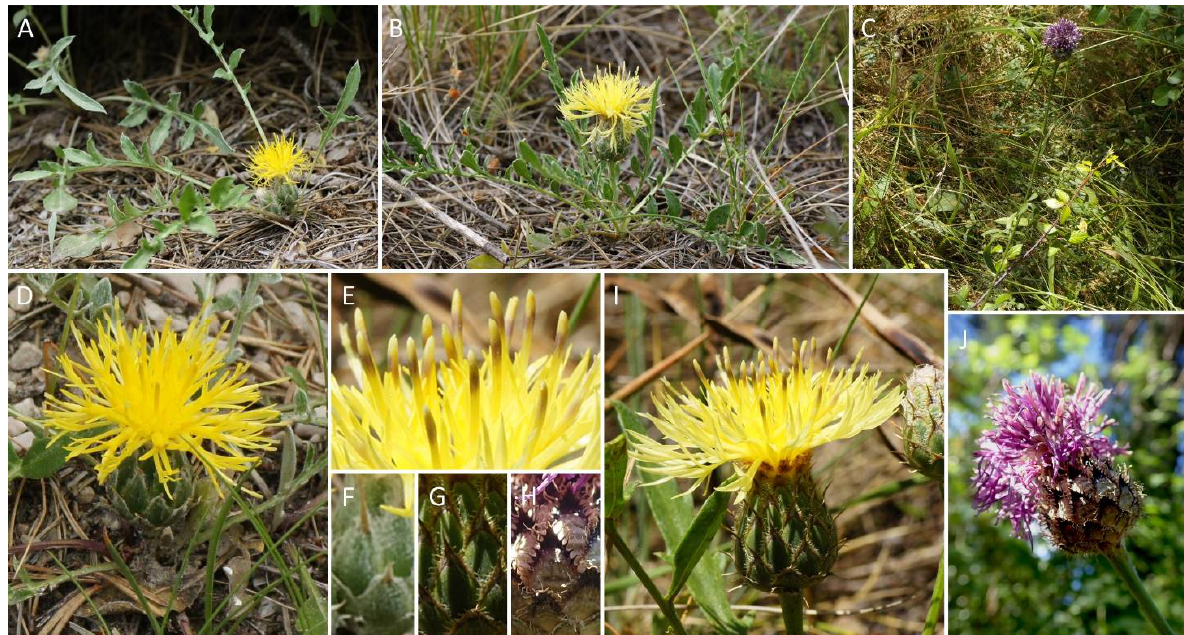
Figure 1. Photographs illustrative of the three Centaurea studied from Ports Massif, including morphological details of the flower head: ( A , D , F ) C. podospermifolia ; ( B , E , G , I ) C. ×loscosii ; ( C , H , J ) C. cephalariifolia (Images: Marc Aixarch, Oriane Hidalgo). Note that specimens of C. podospermifolia from Cardó Massif are morphologically no different from those of Ports Massif (image available at https://twitter.com/agentsruralscat/status/1278388147324243969?lang=ca, accessed on 19 July 2021).